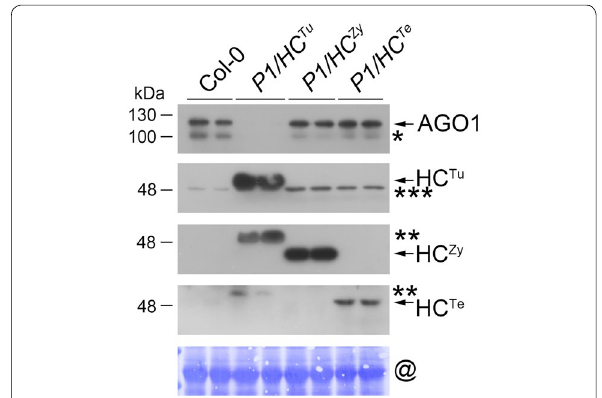
Fig. 5 AGO1 protein detection in different viral P1/HC ‑ Pro transgenic Arabidopsis plants. One asterisk (*) indicates the AGO1 isoform. Two‑asterisk (**) indicates cross‑reaction of the α‑HC Zy or α‑HC Te antibodies. Three‑asterisk (***) indicates common bands. The @ symbol indicates RUBISCO as an internal